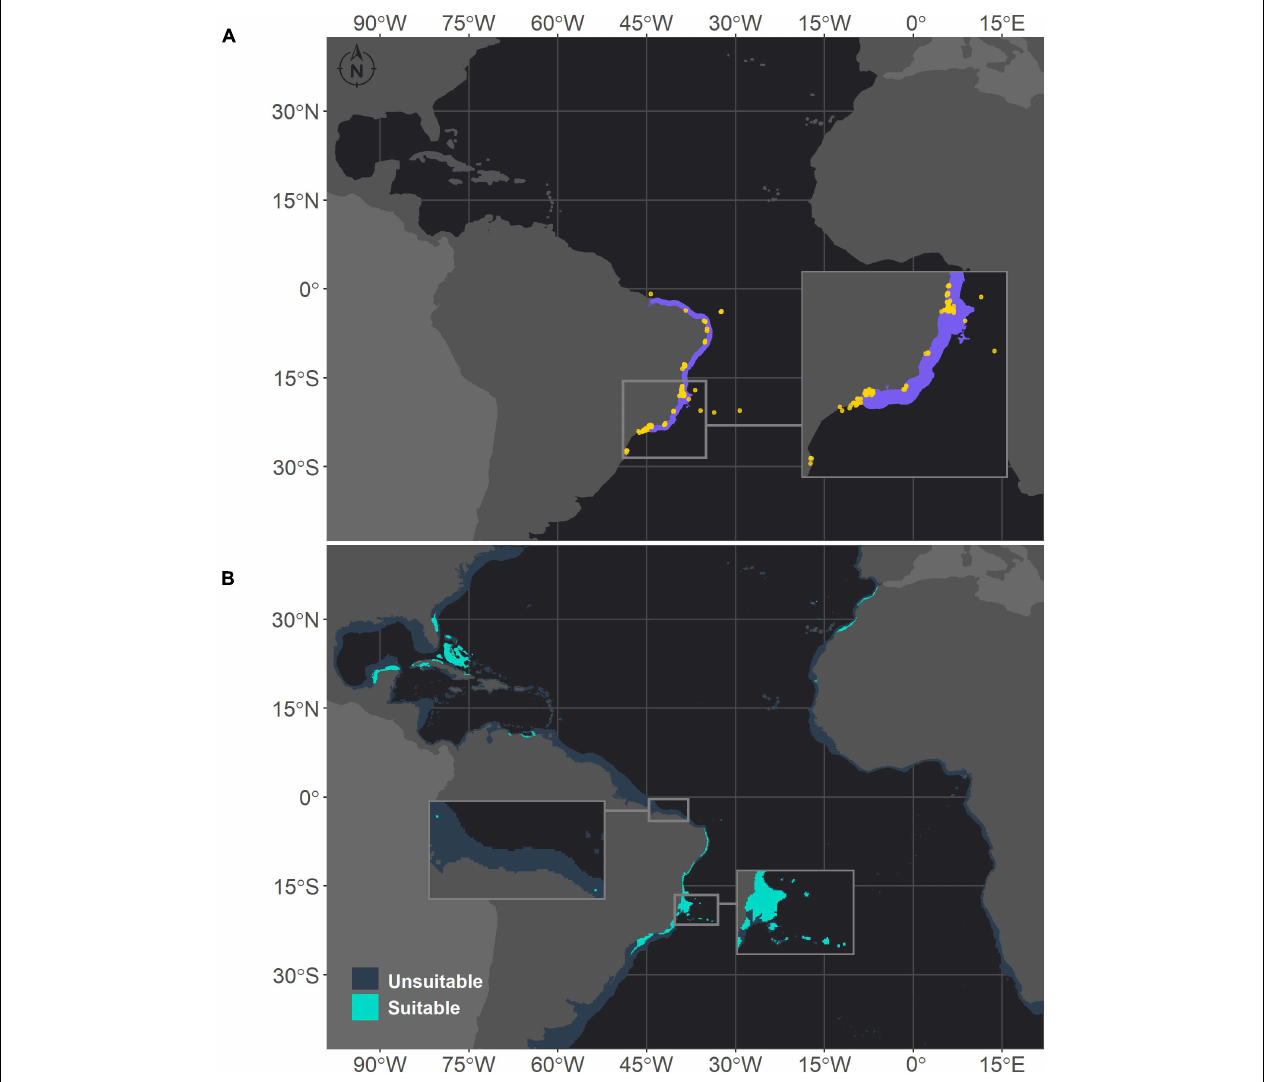
FIGURE 1 | Projected habitat suitability of Mussismilia hispida in the Atlantic obtained through an ensemble modeling approach. Map (A) shows the presence points (in orange) used for training the model and shows (in purple) the expected range of M. hispida according to the IUCN. Map (B) presents the predicted habitat suitability for the current period. In both maps, inset maps show the Abrolhos region, where M. hispida plays a key role as a habitat-forming species. In map (B) , the top inset map highlights the patches of suitable areas in northern